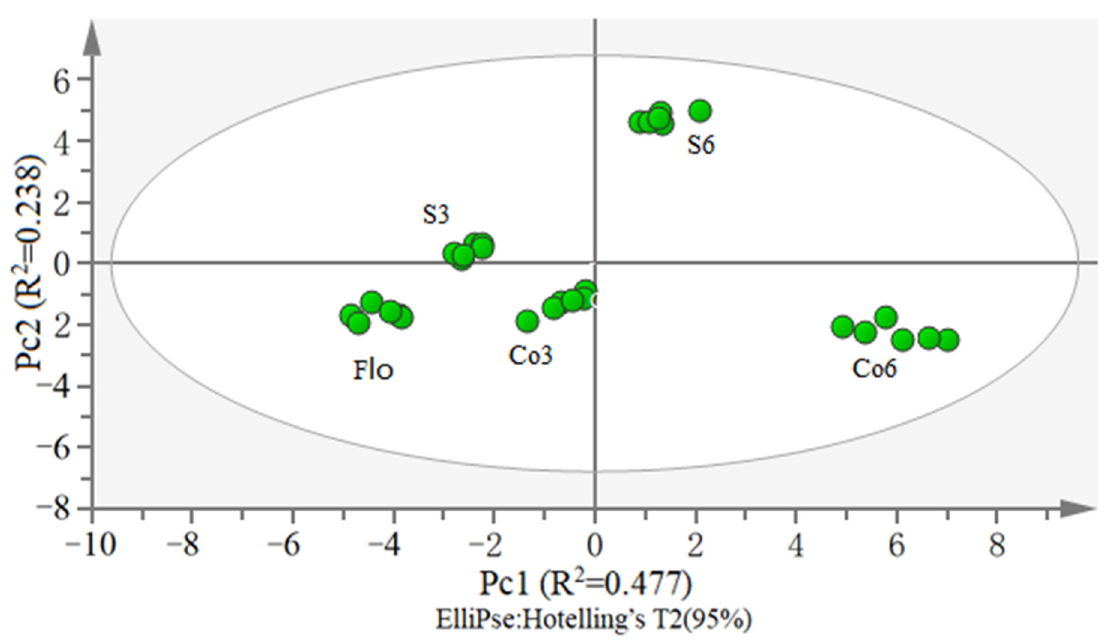
Figure 5. PCA analysis of VOC in sourdough. Flo indicates fresh dough without fermentation. Co4 and Co8 indicate wholewheat sourdough fermented for 4 and 8 h, respectively. S4 and S8 indicate wholewheat sourdough artificially contaminated with S. aureus (10 2 cfu/g) and cultured for 4 and 8 h, respectively ( n = 6).